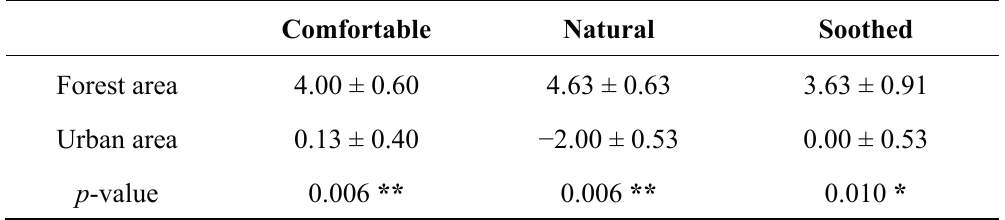
Figure 5. Comparison of subjective scoring for “anger and hostility”, “vigor”, “fatigue”, and “total mood disturbance” by POMS between forest and urban areas. N = 8, mean ± SE, * p < 0.05; ** p < 0.01, determined by Wilcoxon signed-rank test. Table 2. Summary of the comparison of SD method between the forest and urban